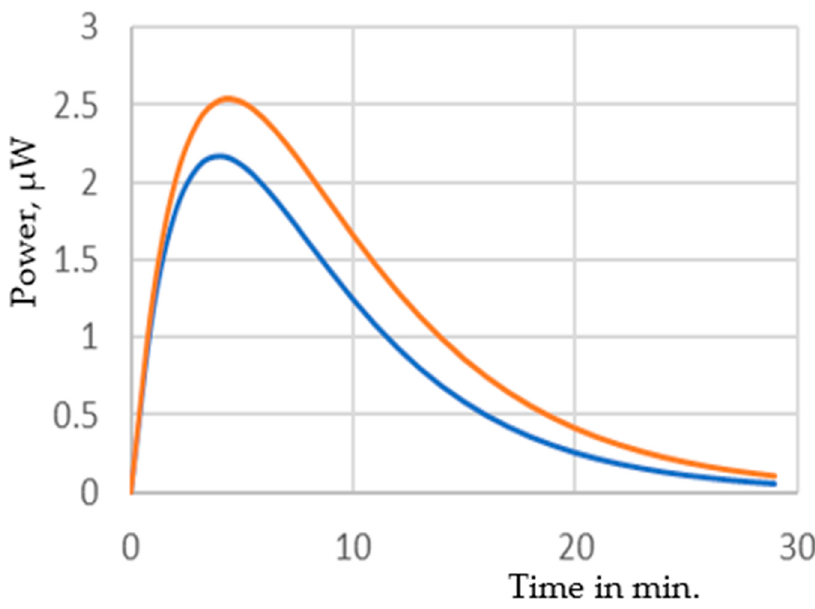
Figure 11. Power harvested from the power line for plate 2 distances of 60 cm (blue) and 120 cm (brown) from the live wire.